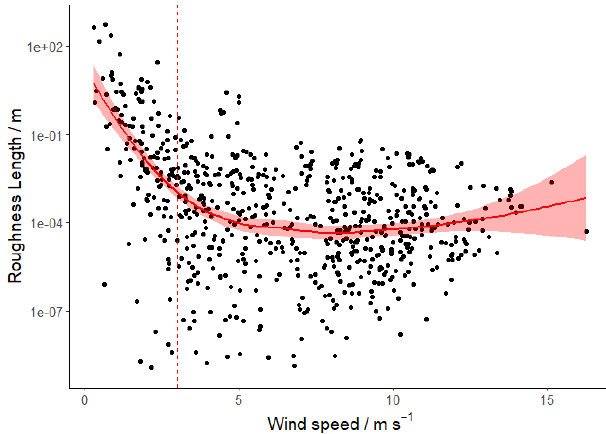
Figure 5. Roughness length for each averaging interval (black dots) with a smoothed local regression (LOESS) line (solid red, 95% con- fidence interval shaded). Points left of the 3ms − 1 filter threshold (dashed red) are not used in subsequent discussions of oceanic de- position velocity. The y axis is limited for clarity, with 17 points < 10 − 9 m not shown. Table 1. Selection criteria applied to calculated fluxes, with the number (and percent) of points